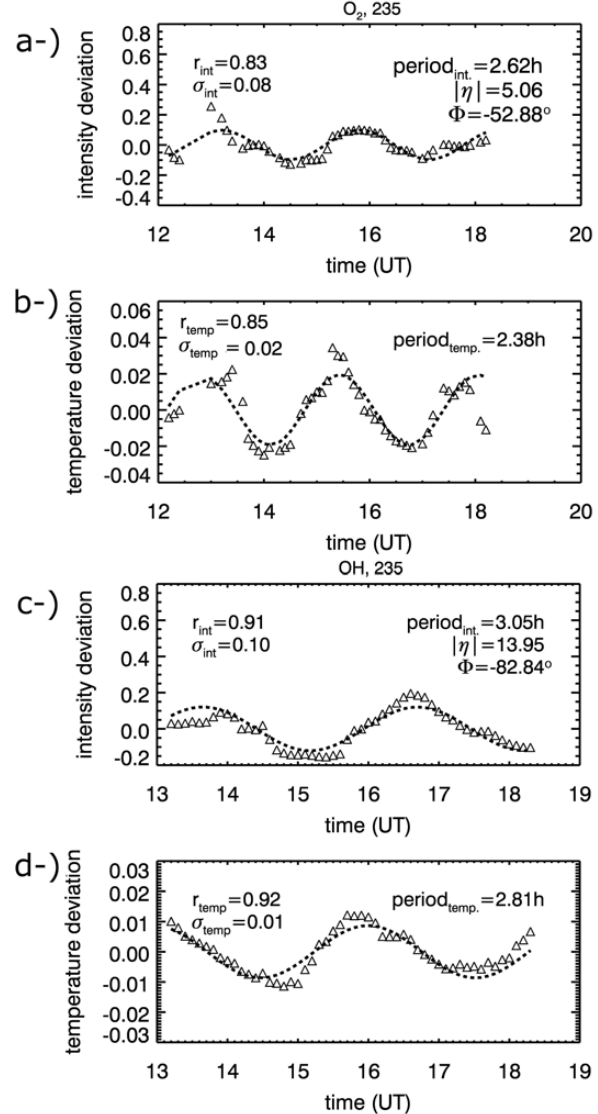
Fig. 1. Normalized nocturnal variations of O 2 b emission inten- sity (a) and the rotational temperature (b) , the OH(6-2) emission intensity (c) and the temperature (d) in the night of 22 August 2004. The dashed lines are least mean square fitting using harmonic anal- ysis. “ r ” and “ σ ” indicate respectively correlation coefficient and STD deviation between the observed and fitting. “ η ” and “ 8 ” repre- sent, respectively, Krassovsky coefficient and the phase difference between the intensity and temperature variations. The local mid- night is